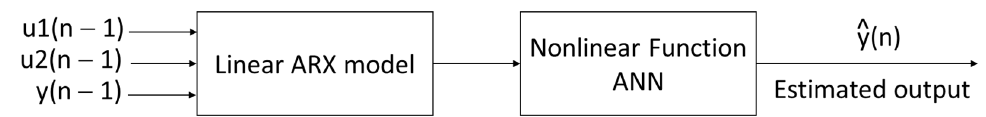
Figure 9. Results of estimation with the use of the ARX model: ( a ) measurement at point A on the workpiece; ( b ) measurement at point B on the workpiece.